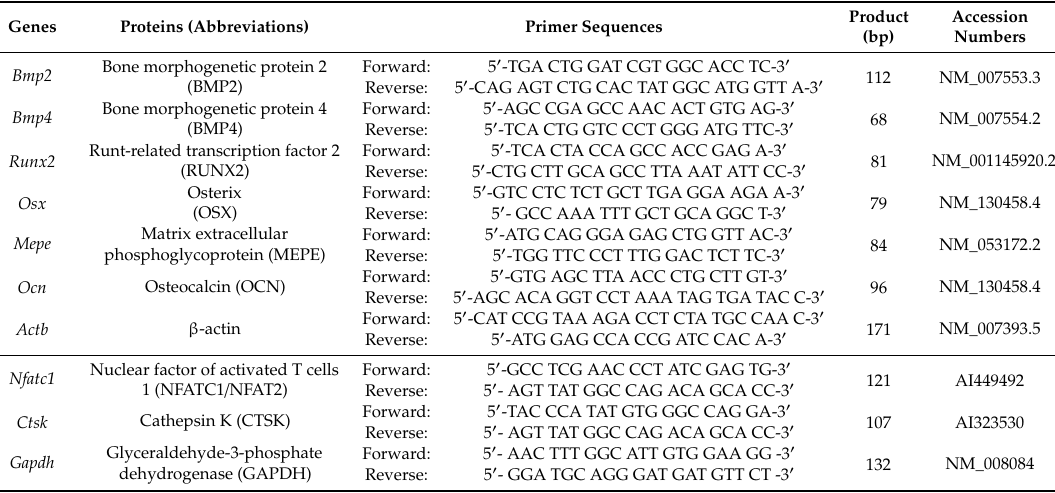
Table 1. Specific primer